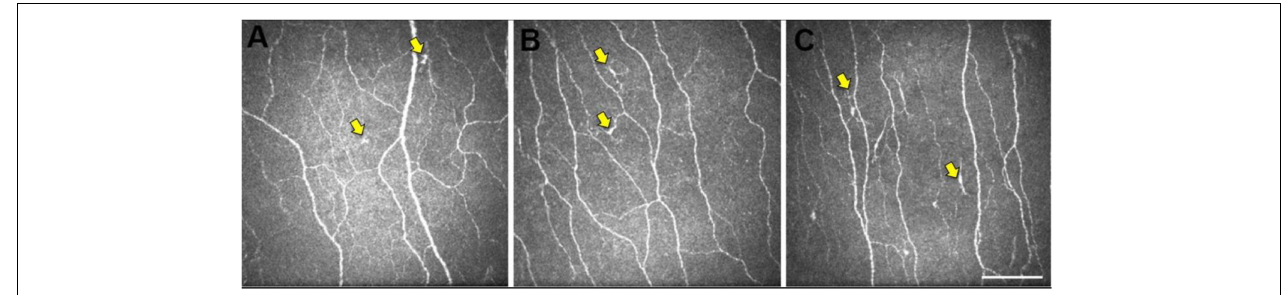
FIGURE 2 | Representative central corneal in vivo corneal confocal microscopy (IVCCM) images from the central corneal sub-basal nerve plexus from participants in the control (A) , mild cognitive impairment (MCI) (B) , and AD (C) groups. The epithelial dendritic cells (DCs) (yellow arrows) are smaller and less stratified in CN eyes (A) relative to the larger, more stratified morphology of DCs in MCI and AD eyes. Scale bar: 100 µ m, applies to all images [image courtesy of reference (Dehghani et al., 2020)].